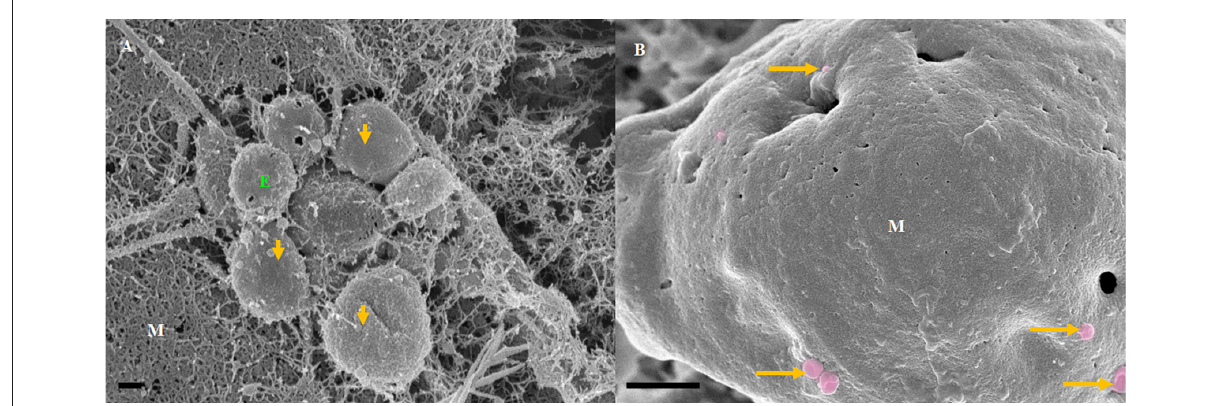
FIGURE9 The transient emerging and fusion of the exosome on the plasma membrane of a BEC. (A) An untreated control BEC displaying exosome extrusion onto the BEC extracellular membrane surface. M denotes the porous, cell membrane. E denotes an exosome which is indicated by orange which may eventually fuse with the adjacent exosomes and give rise to a TUNT. Scale bar = 200 nm. (B) The Tipifarnib-treated BEC displays an observable decrease in exosome formation on the extracellular membrane surface upon treatment with 1 µ M of Tipifarnib, indicated by the orange arrows. Scale bar = 2,000